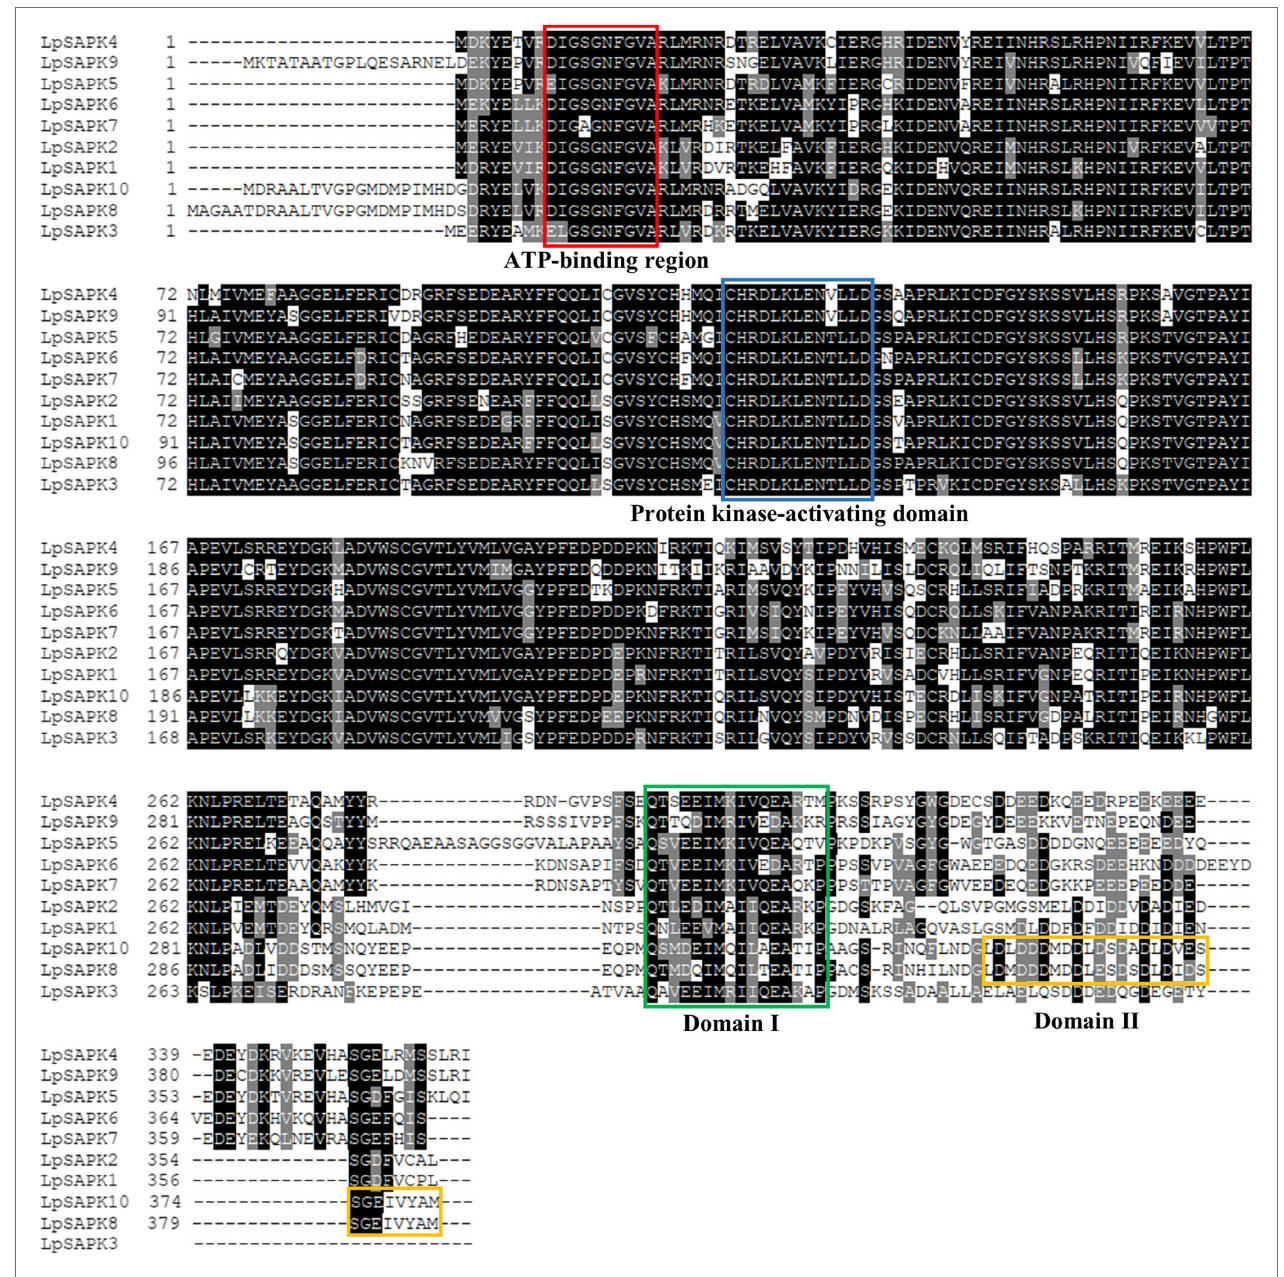
FIGURE 1 | Multiple sequence alignment of LpSAPKs . The protein kinase ATP-binding region signature and the serine/threonine-protein kinase active-site signature were indicated by a red box and a blue box, respectively. Domain I and Domain II at the C-terminus were marked by a green box and a yellow box,